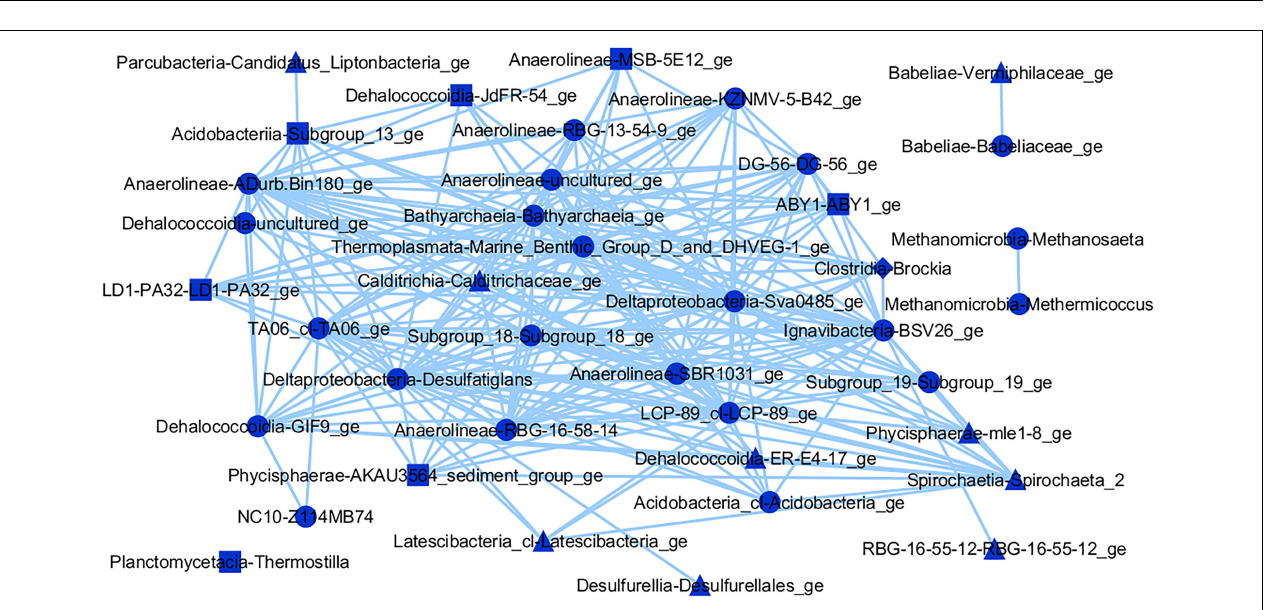
FIGURE 7 | Interaction network of microbial genera in the brown module (threshold = 0.15), which presented positive correlation ( p ≤ 0.05) with CH 4 (triangles), CO 2 (squares), or both gases (circles).